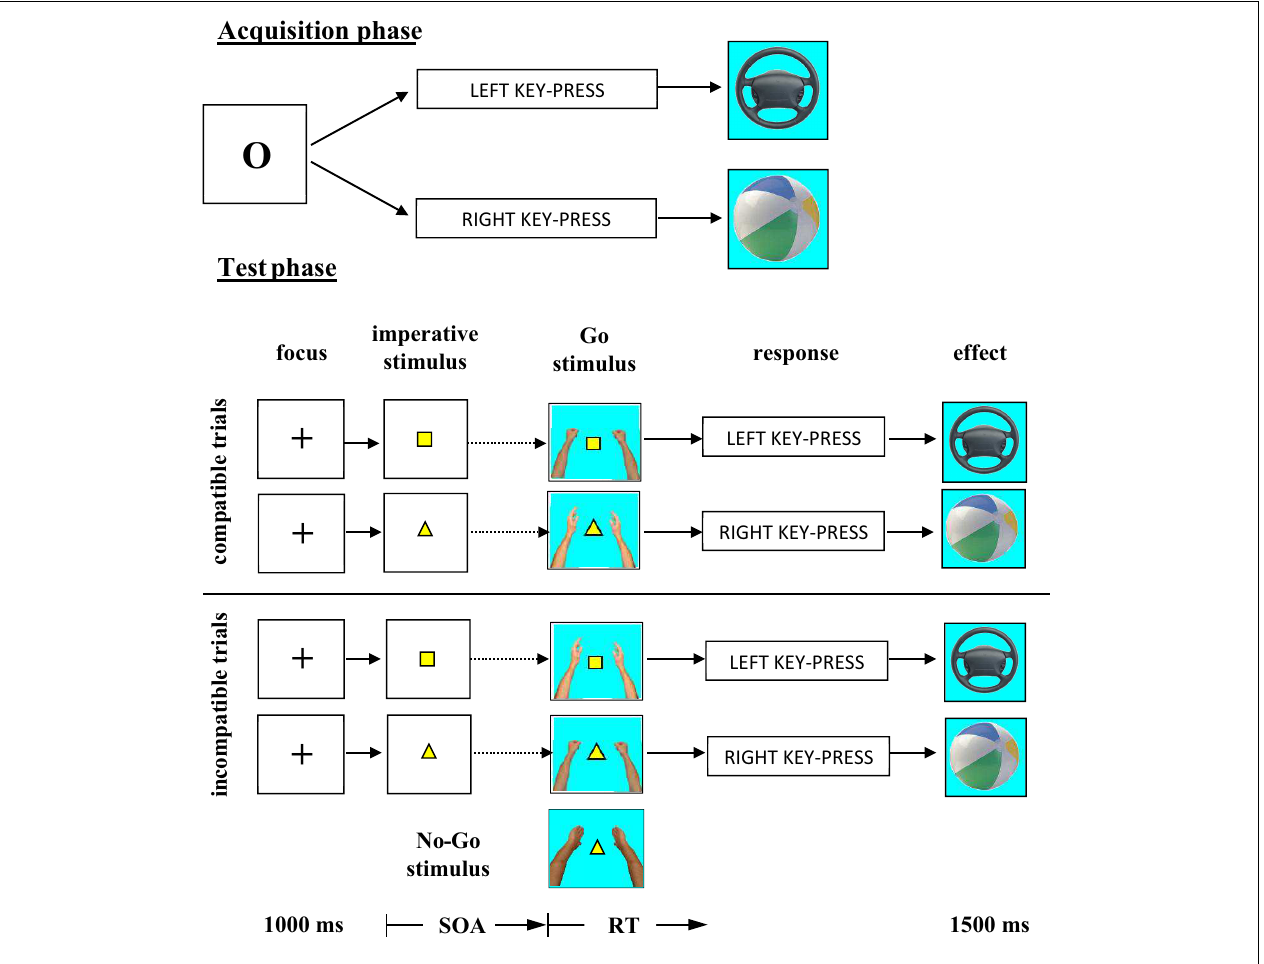
FIGURE 1 | Material and design used in Experiment 1. The SOA was 0, 100, or 200ms.